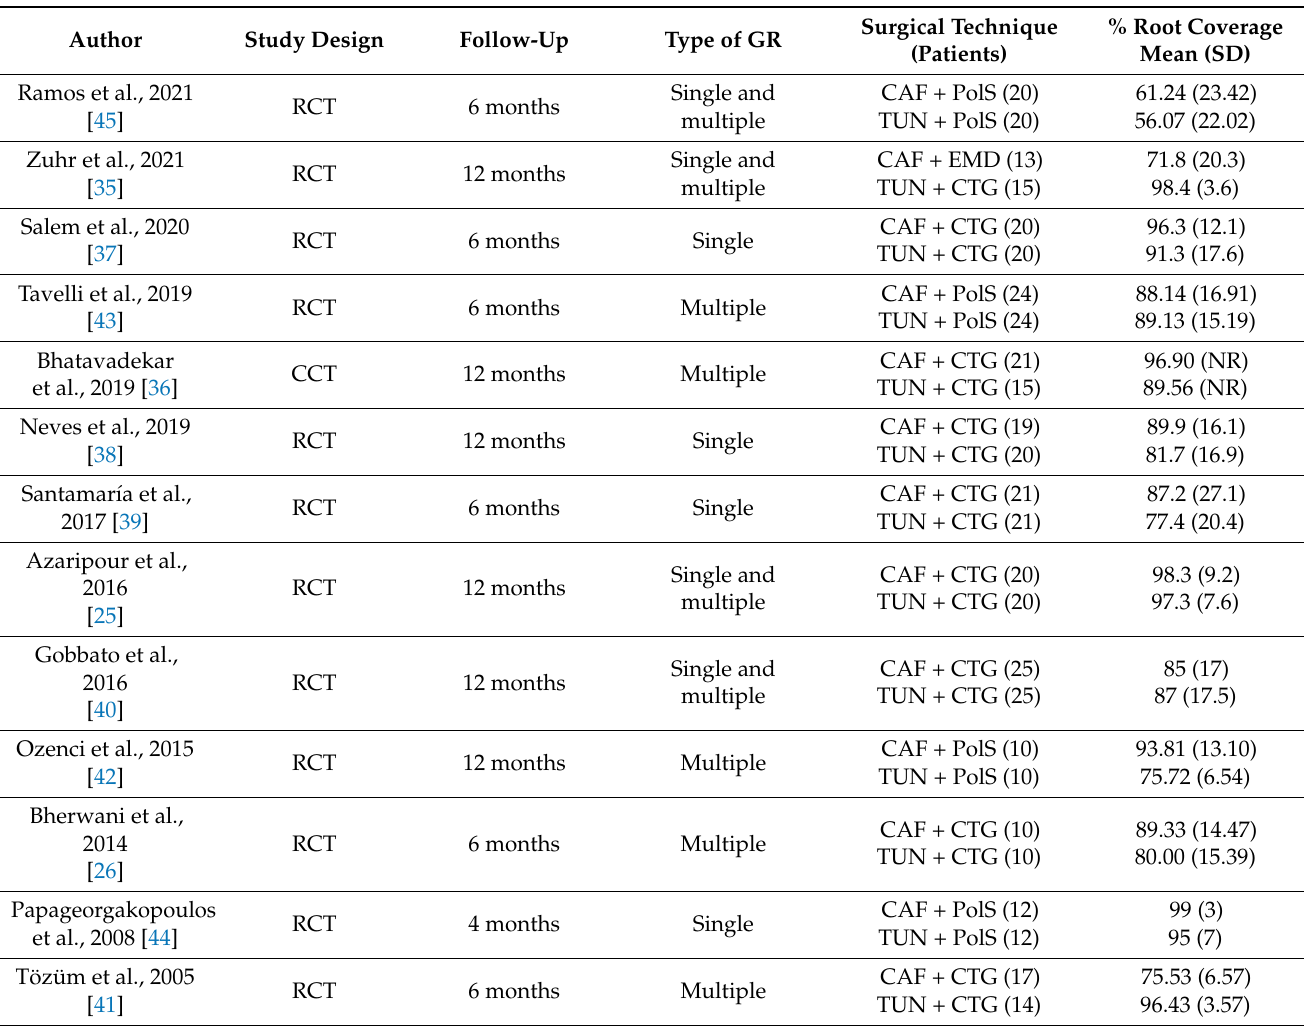
Table 2. Main characteristics of the included studies investigating the surgical technique used for gingival recession treatment with the primary